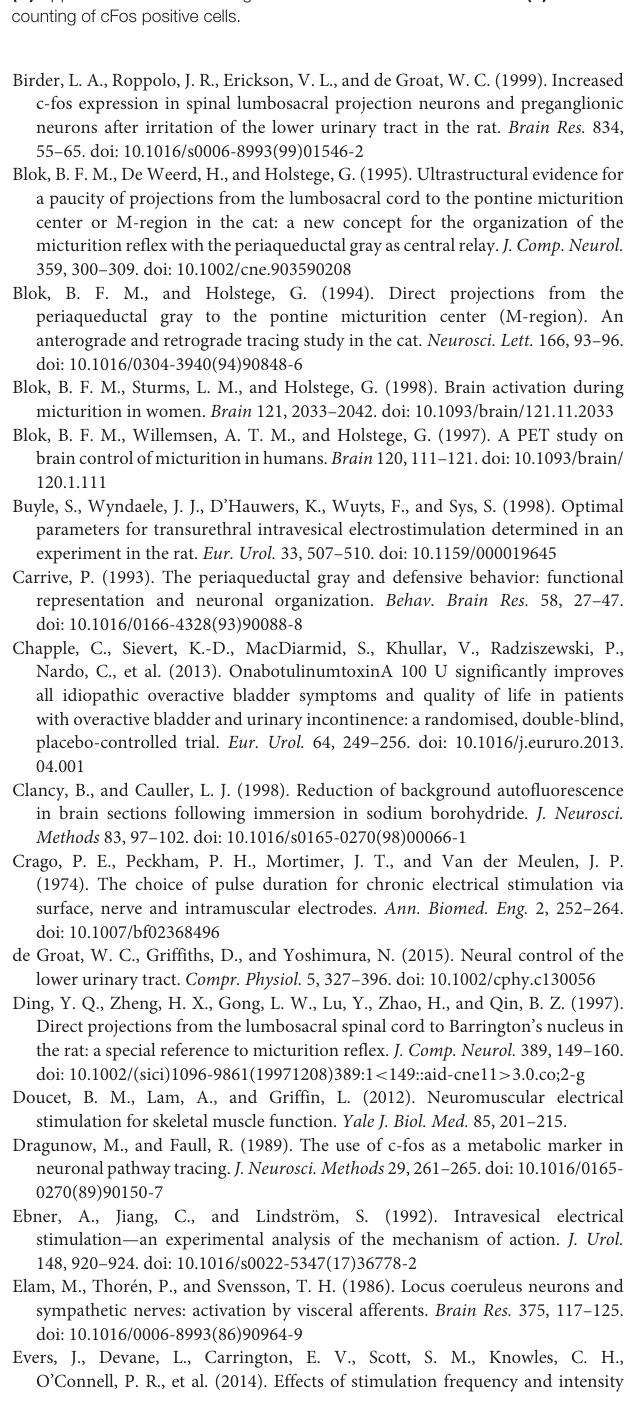
cFos and delineated for the PAG. Note that the dark spot on bottom left side of photomicrographs is due to an imperfection in the 4 × objective but did not interfer with delineation of the columns and the quantification of the cell number performed on photomicrographs taken with 10 × magnification. FIGURE S2 | Methodological process for the quantification of cFos immunoreactive cells. Acquisition of the photomicrographs from the region of interest with a low magnification (4x) (A) for the delineation of the PAG (B) . (C) Delineation of the columns of the PAG with a higher magnification (10x). (D) Application of a thresholding method on the delineated sections. (E) Manual counting of cFos positive